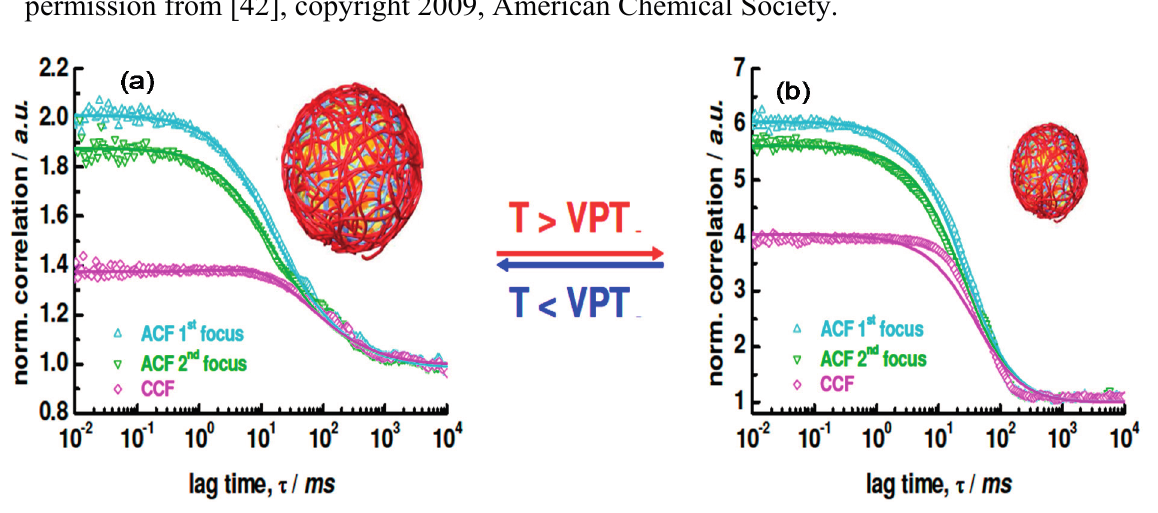
Figure 15. 2 f -FCS curves of uncoated rhodamine labeled NG detected at two different foci (ACF1 and ACF2) and cross-correlated (CCF) at ( a ) 25 °C and ( b ) 40 °C. Reproduced with permission from [42], copyright 2009, American Chemical